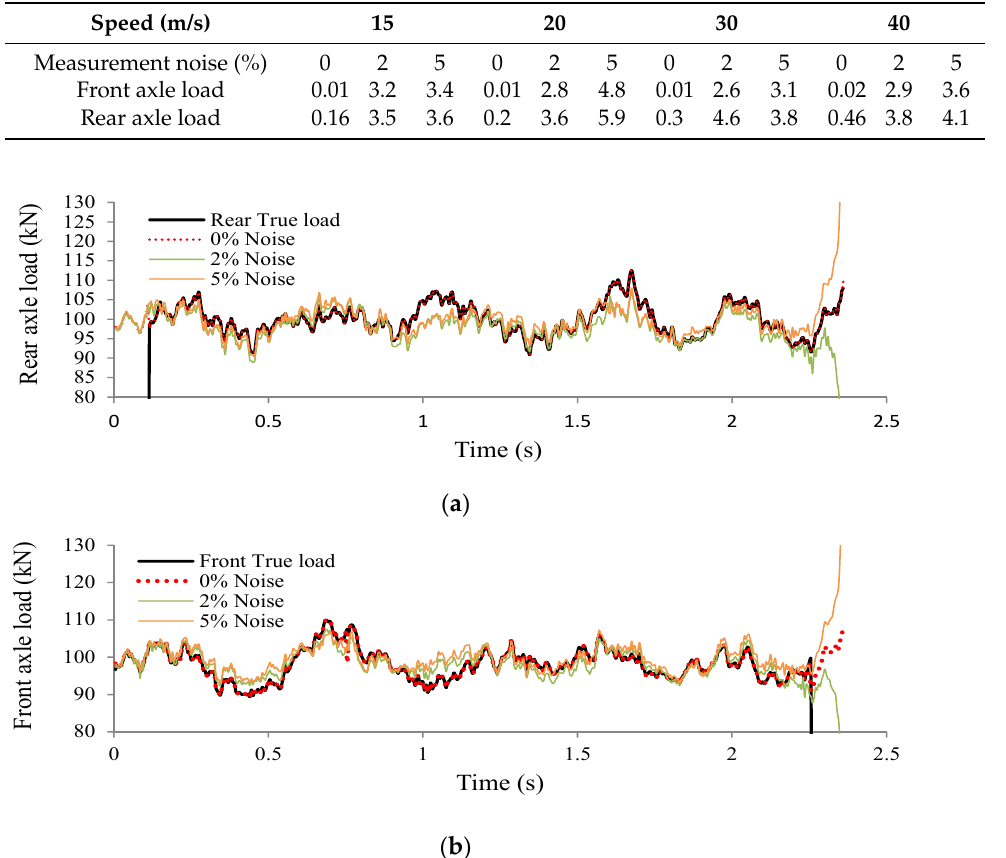
Table 6. Percentage errors of the identified moving loads at different levels of speed and noise.